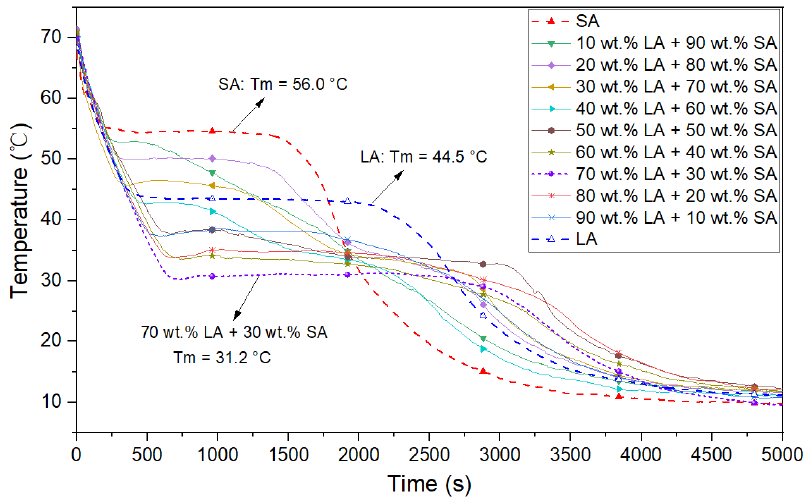
Figure 6. Experimental tests of the eutectic melting point of LA and SA.